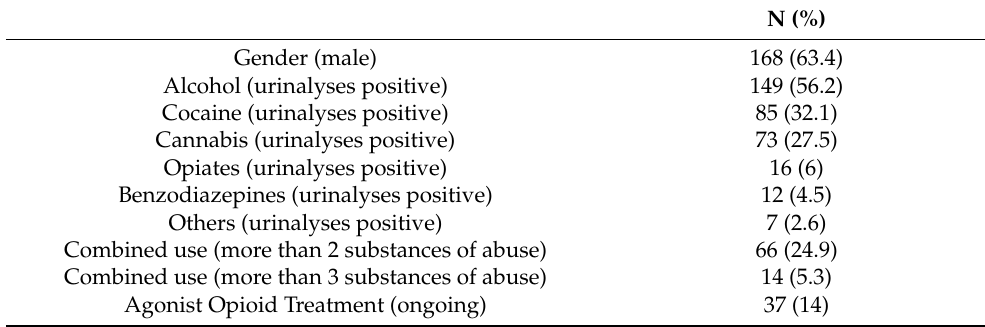
Table 1. Descriptive